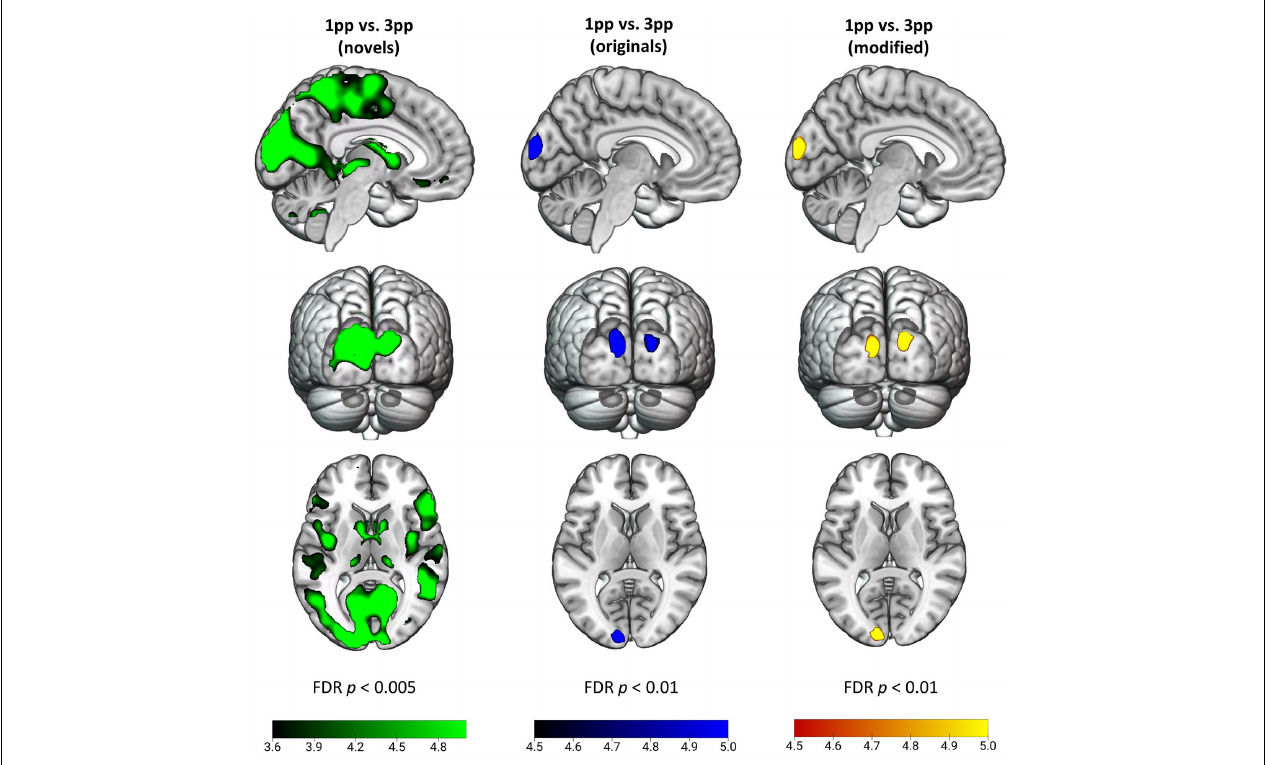
FIGURE 8 | Effects of perspective for novel (green), original (blue), and modified (yellow) stories. Activity patterns indicate enhanced activity for a first-person perspective (1pp) compared to a third-person perspective (3pp). For better visualization we show t-maps at p < 0.005 (FDR-corrected) for the novel videos, and p < 0.01 (FDR-corrected) for original and modified videos. New videos presented from 1pp led to increased activity in supplementary motor area, thalamus, posterior insula, cuneus, supramarginal gyrus and inferior frontal gyrus among others. Original and modified videos showed more engaged activation in bilateral cuneus.